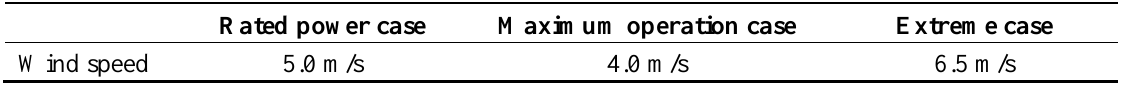
Table 4. The test wind speeds under three typical wind load